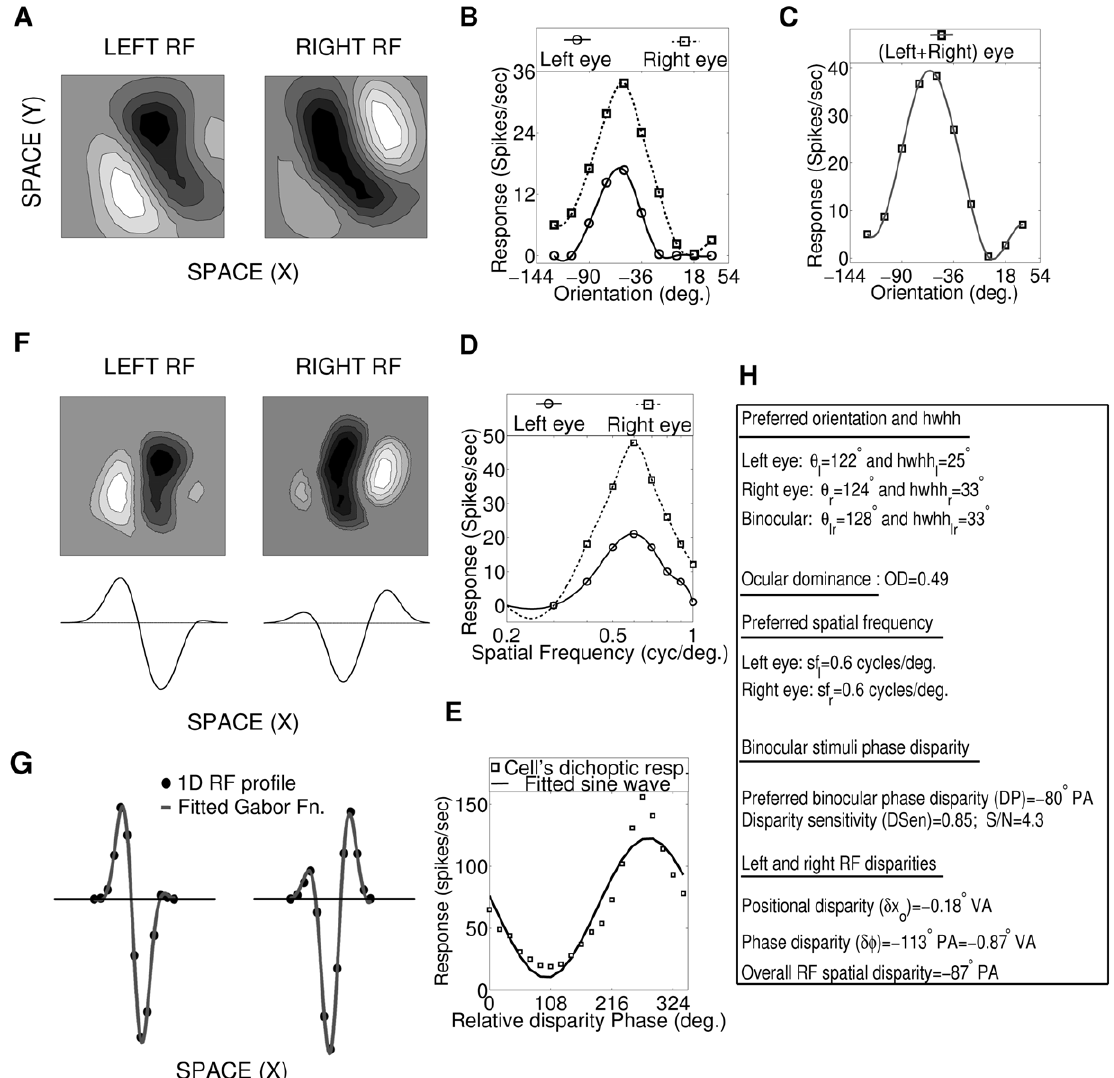
Figure 2. Simple cell response characterization. (A) Left and right 2D spatial (X-Y) RFs of a sample cortical cell from our 50 6 50 cortex. The ON and OFF subregions are shown in Grayscale with white (black) color representing strong synaptic connection from ON (OFF) LGN cells. The shading is proportional to the strength of the ON/OFF synaptic connections from LGN cells. (B) Left and right monocular OR tuning curves of the cell in ‘A’. Right eye response (maximum=34 spikes/sec) dominates over left eye response (maximum=17 spikes/sec). The OR preferences in left and right eyes are 122 u and 124 u (OR preference difference=2 u ), with hwhh of 25 u and 33 u respectively. Eye preference i.e OD is 0.49. (C) Binocular OR tuning curve of the cell in ‘A’. The binocular OR preference is 120 u with hwhh of 38 u . (D) Left and right SF tuning curves of the cell in ‘A’. The optimal SF in left and right eye are 0.6 and 0.6 cycles/degree respectively. (E) Disparity tuning curve for the cell in ‘A’. The DP is 2 80 u PA, DSen is 0.85 and S/N is 4.3. (F) 2D left and right spatial RFs of the cell in ‘A’ with X-axis transformation such that X-axis is orthogonal to cell’s preferred orientation. 1D RF profiles is shown below the X-axis transformed 2D RFs. (G) 1D RF profiles marked with dark filled circles and fitted Gabor functions with solid curves for the cell in ‘A’. The positional disparity ( d x o ) is 2 0.18 u VA and phase disparity ( dw ) is: 2 113 u PA and 2 0.87 VA. The overall RF spatial disparity is 2 87 u PA (H) Summary of the characterization of the sample cell in ‘A’.